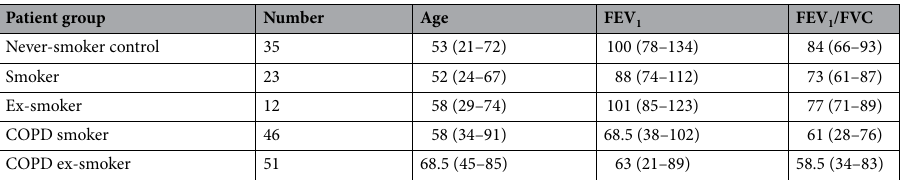
Table 2. Demographics of patients who underwent BAL and/or EBC collection. Data represents the median and the min and max of all patients in each group. Not all patients were used for each experiment. FEV 1 data is presented as percentage of predicted